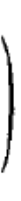
Figure 1. Molecular structure of PVTMS.